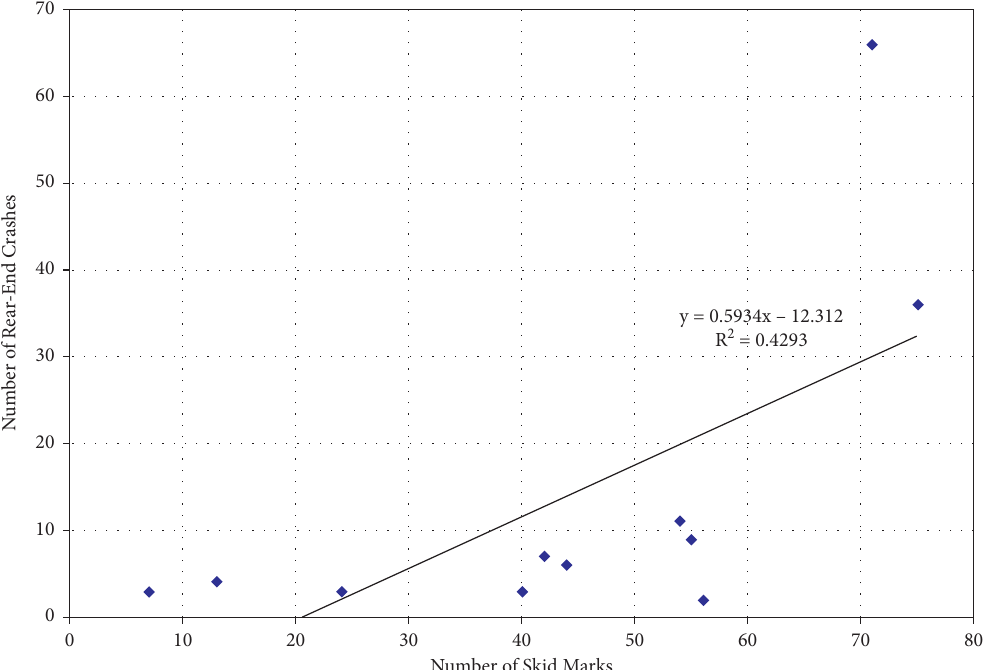
Figure 8: Rear-end crash vs. skid correlation by 1-mile segments on Interstate 80